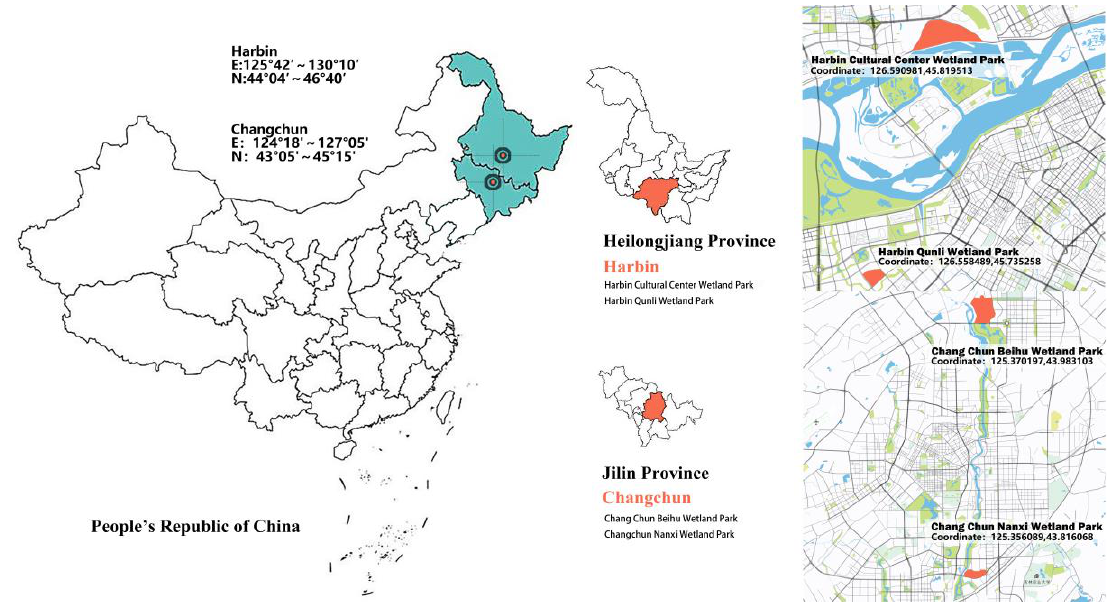
Figure 1. Location of the four urban wetland